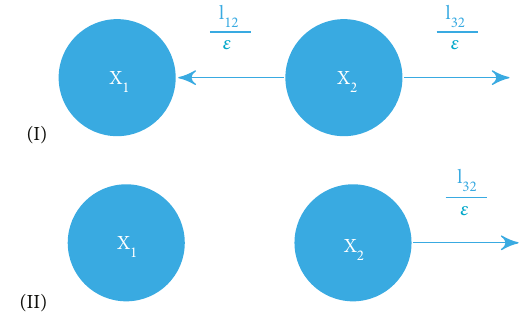
Figure 6: Possible scenarios where l metabolites and one output. Both cases represent a fl ux trap in X